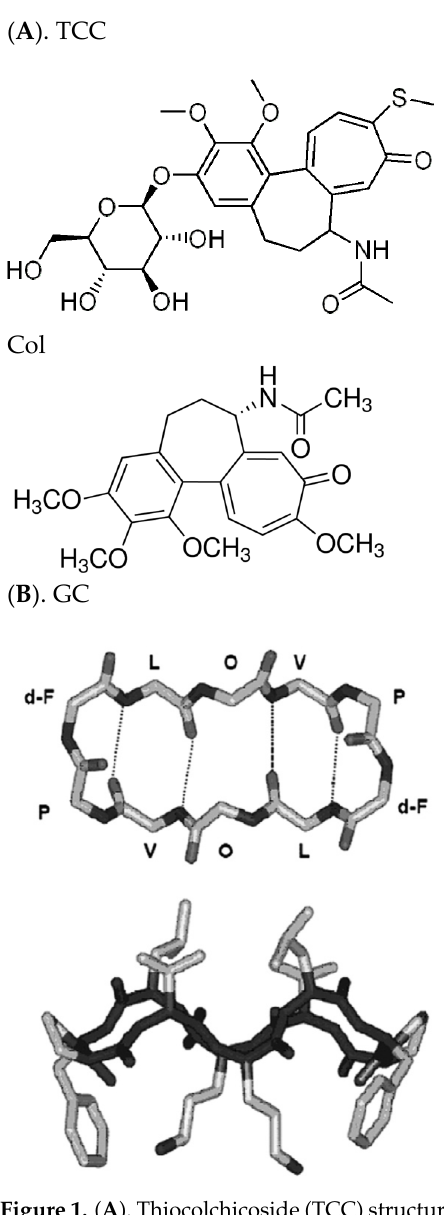
Figure 1. ( A ). Thiocolchicoside (TCC) structure [1,2] and Col structure (see Sigma, www.sigmaaldrich. com accessed on 29 February 2021). ( B ). Gramicidin S (GS) structures [9]. The top panel ( B ) shows a three-dimensional (3D) view of the GS molecule perpendicular to the plane of the ring, which illustrates the peptide backbone structure and the positions of the hydrogen bonds in the antiparallel β -sheet region. The bottom panel shows a view in the plane of the ring, which indicates the spatial disposition of the hydrophobic Val and Leu residues (top) and the basic Orn residues (bottom) relative to the peptide